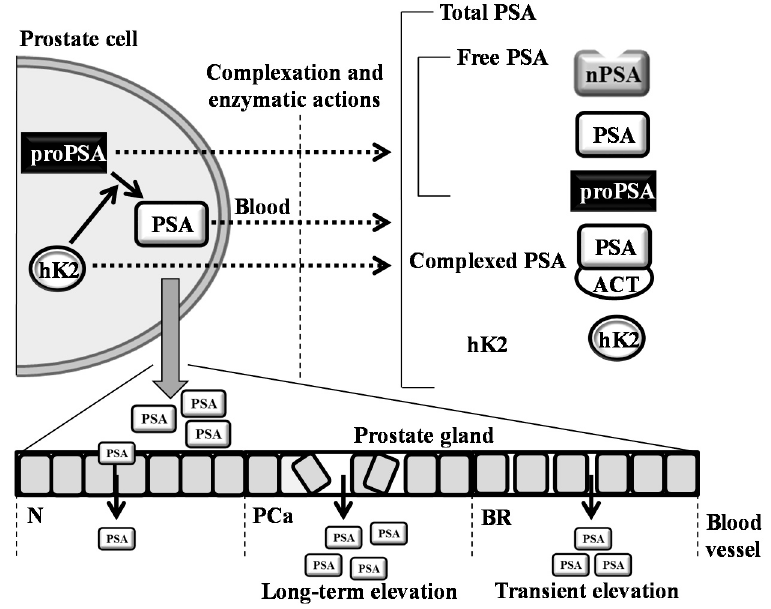
Figure 4. Schematic depiction of the formation of PSA variants and kallikrein-related peptidase 2 (hK2). hK2 proteolytic activity probably removes propeptides from PSA, forming its mature, catalytic form. Secreted PSA is complexed or enzymatically inactivated to form free PSA forms (nicked PSA (nPSA), proenzyme form of PSA (proPSA) and intact PSA) and complexed PSA (PSA complex with ACT (1-antichymotrypsin)). In normal conditions (N), cells in the prostate are healthy and organized in a tight pattern. Hence, only a small amount of PSA leaks into the bloodstream. In prostate cancer (PCa), cells are disorganized, and the layers between the prostate and bloodstream become disrupted. Thus, more PSA is leaked into the blood. During bicycle riding (BR), cells are likely irritated and forming the pores for the transient leakage of PSA into blood. This phenomenon can significantly affect the clinical performance of PSA. The dotted arrows represent the transition of molecules from the intracellular to the extracellular regions.